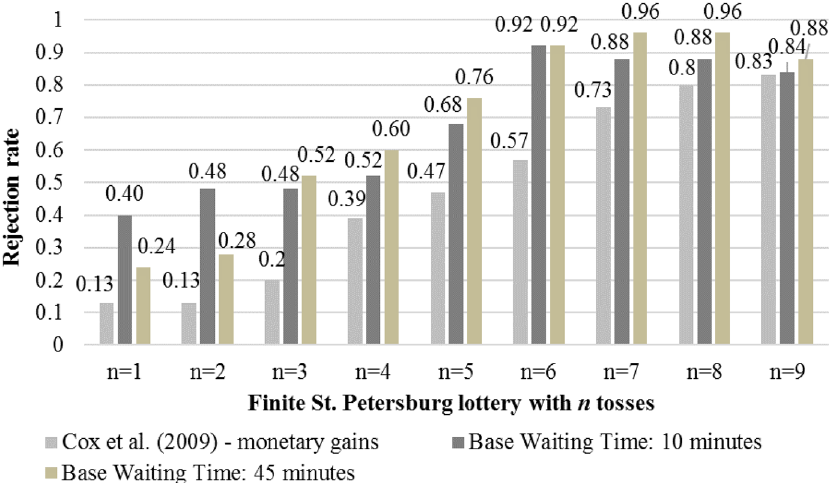
Fig. 2 Comparison of rejecting St. Petersburg lotteries of money risk-averse and time risk-seeking